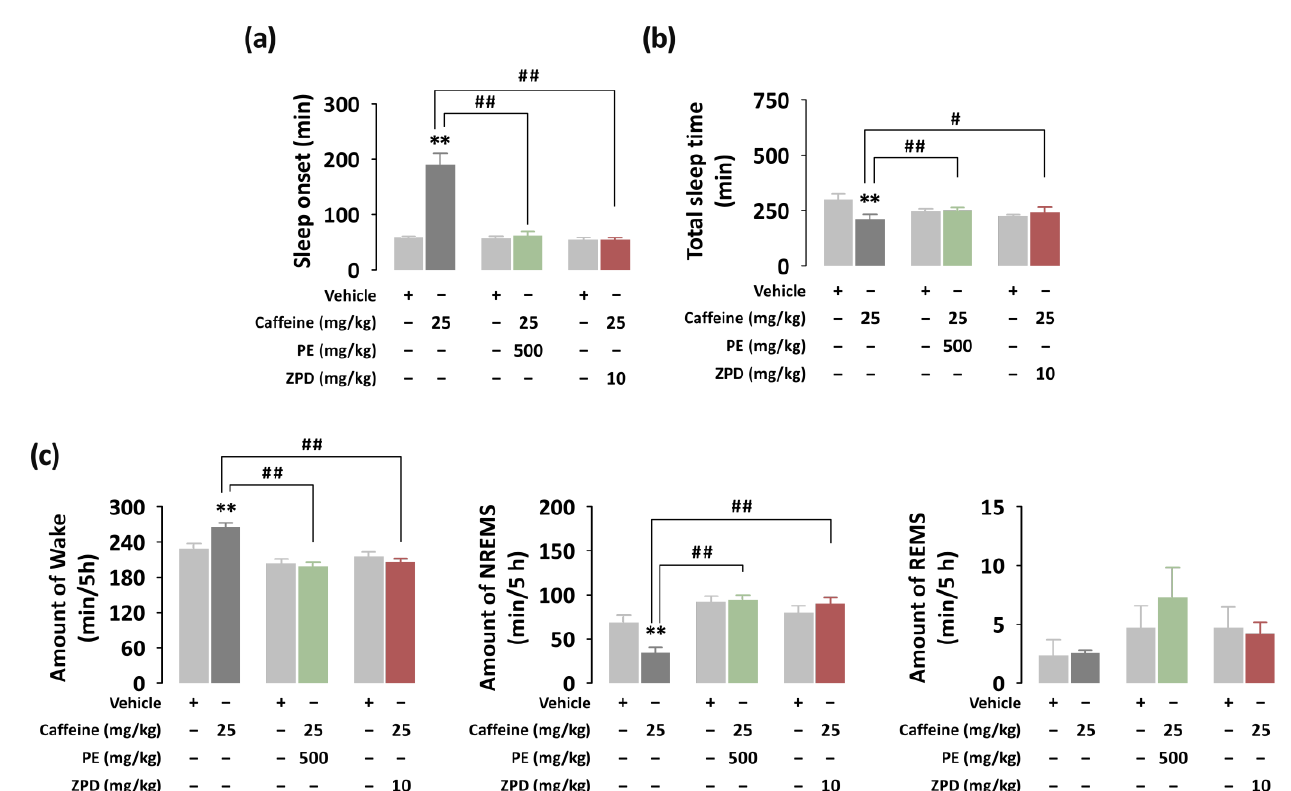
Figure 3. Sleep–wake profiles in C57BL/6N mice after oral administration of caffeine alone, caffeine + PE, and caffeine + ZPD. ( a ) Effects of caffeine alone, caffeine + PE, and caffeine + ZPD on sleep onset. ( b ) Effects of caffeine alone, caffeine + PE, and caffeine + ZPD on total sleep time during the dark period. ( c ) The duration of Wake, NREMS, and REMS during the 5 h period after the administration of vehicle, caffeine, caffeine + PE, and caffeine + ZPD. Each value represents the mean ± SEM ( n = 7 – 8 per group). ** p < 0.01, significantly different from the vehicle control (paired Student’s t -test) and # p < 0.05, ## p < 0.01, significant difference between two groups (unpaired Student’s t -test).